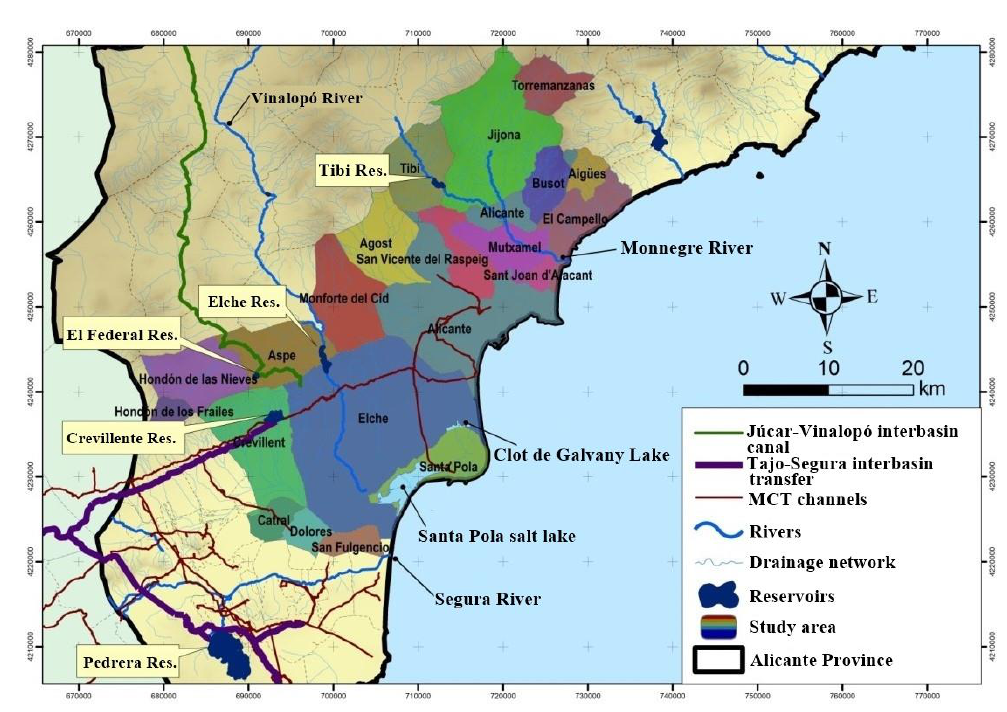
Figure 3. Endogenous and exogenous surface water resources. Source: elaborated with information from [34 – 37].